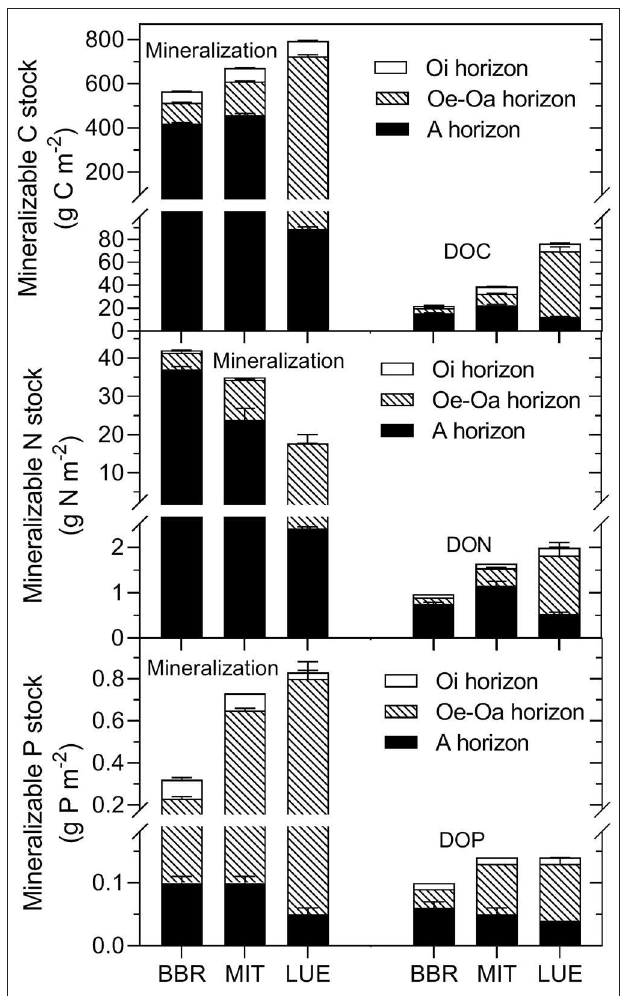
FIGURE 4 | Mineralizable C, N, and P stocks in the Oi, Oe-Oa, and A horizons estimated by multiplying cumulative net mineralization rates with the corresponding soil stocks. Means and standard errors of four replicates of the permanent moist